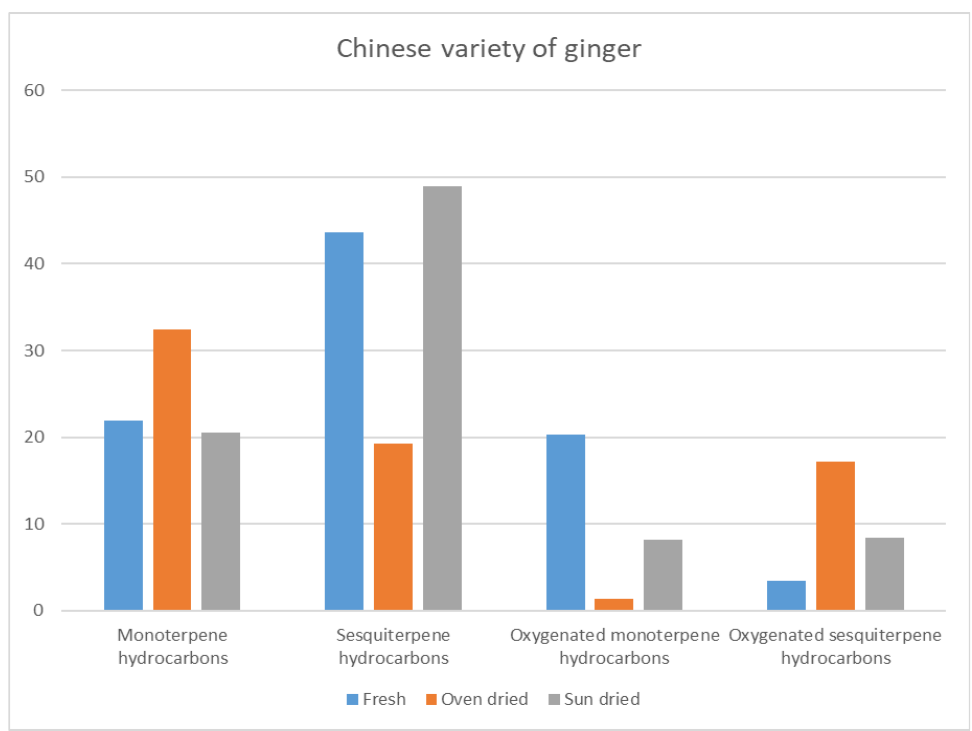
Figure 1. Variations in major classes of compounds in essential oils of fresh, OD, and SD pretreatment of China ginger.